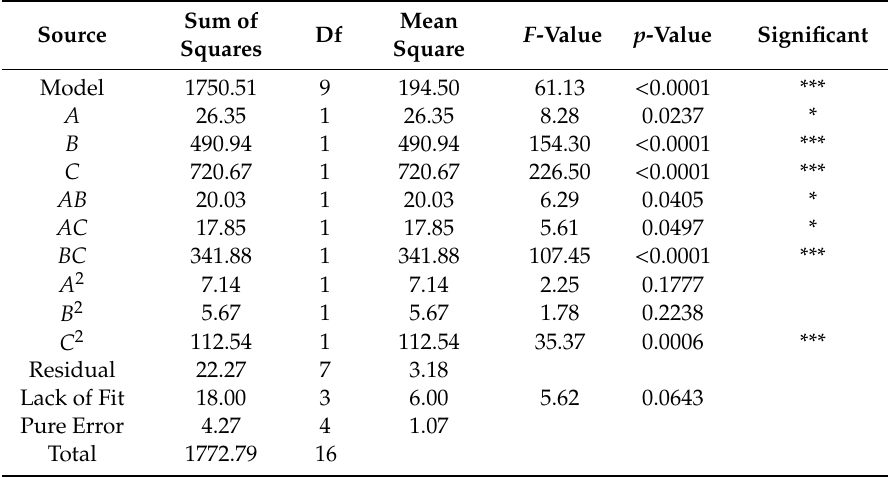
Table 5. Analysis of variance table for the Q ij